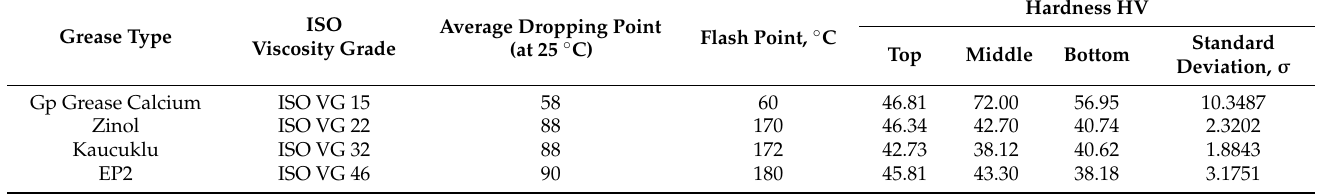
Table 8. Effects of different grease types on hardness.